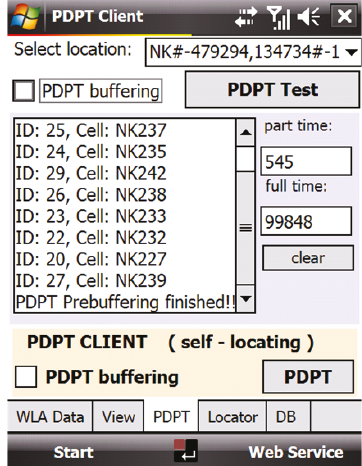
Figure 5: PDPT Client. View of prebu ff ered artifacts (building computer network plans) from Microsoft SQL Server CE database.